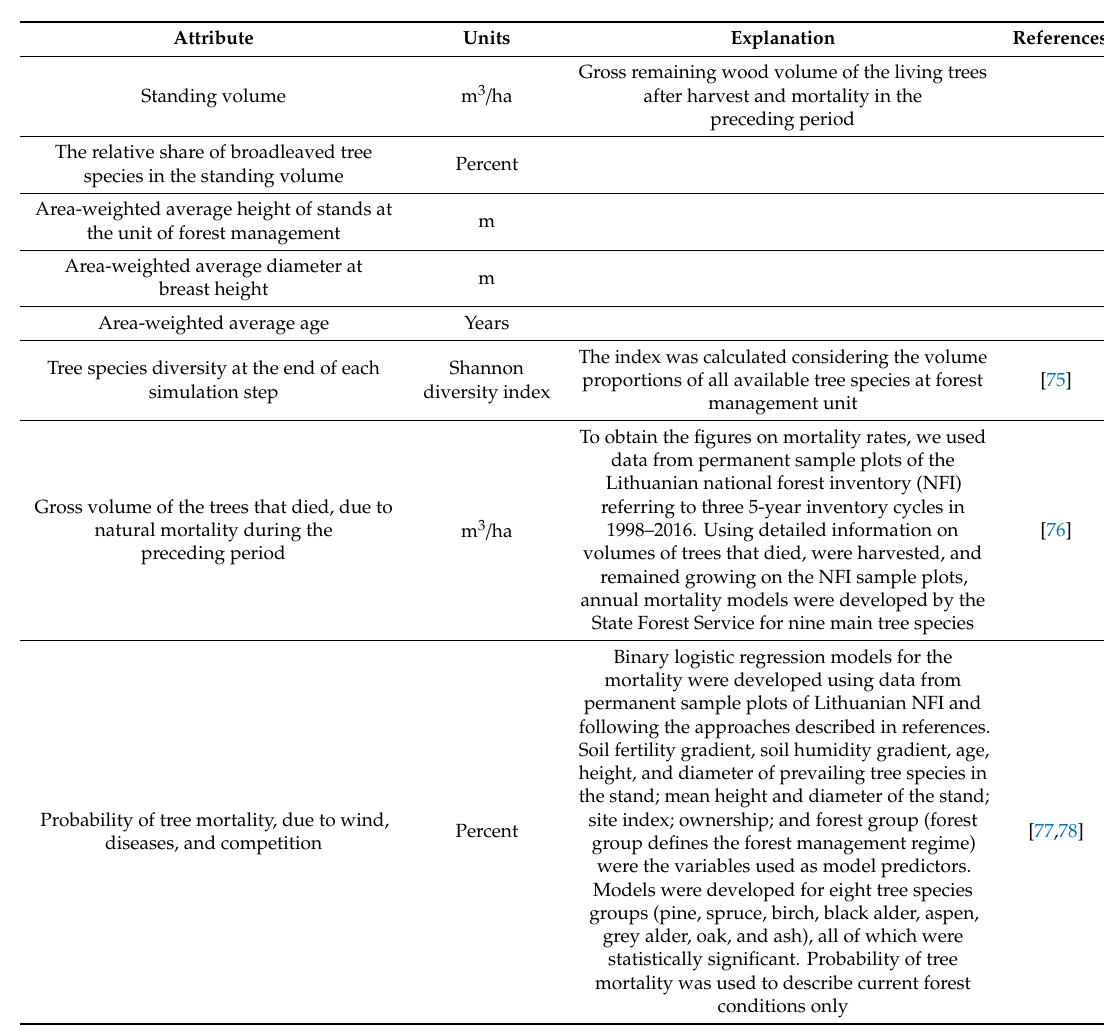
Table A1. Assessed forest